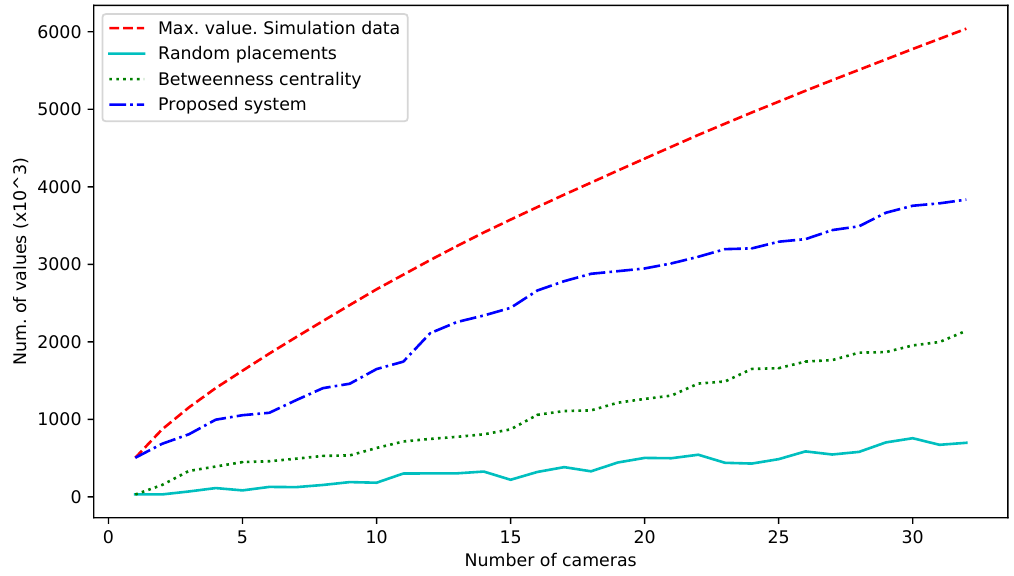
Figure 6. Number of values counted by camera